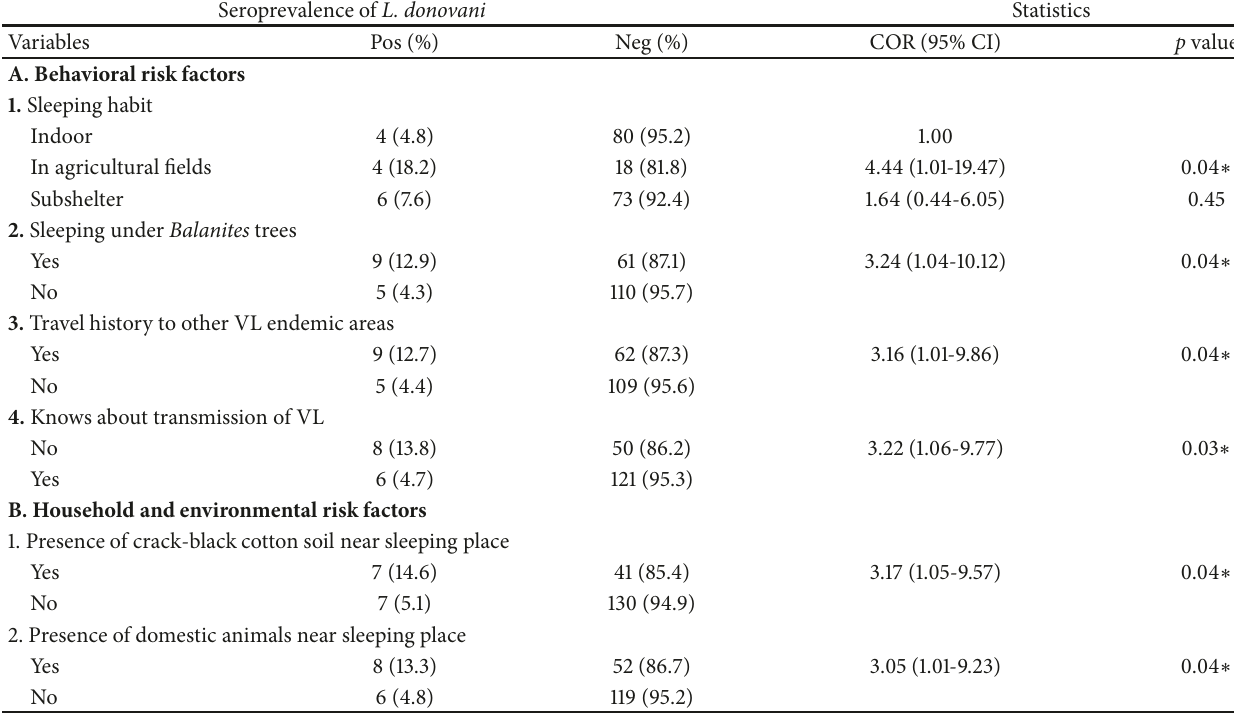
Table 3: Bivariable logistic regression of risk factors in relation to the seroprevalence of asymptomatic Leishmania donovani . Seroprevalence of L. donovani